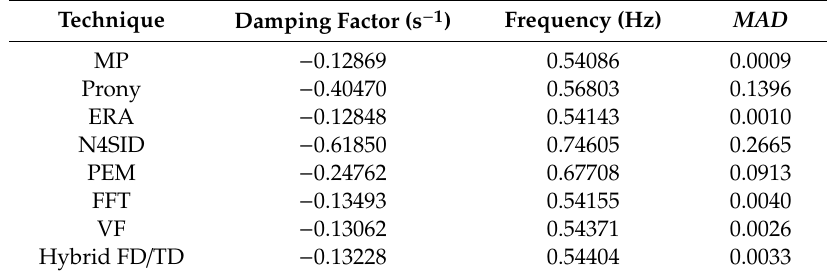
Table 1. Impact of multi-signal analysis on the accuracy of the mode estimates. Mean values acquired from eight signals.